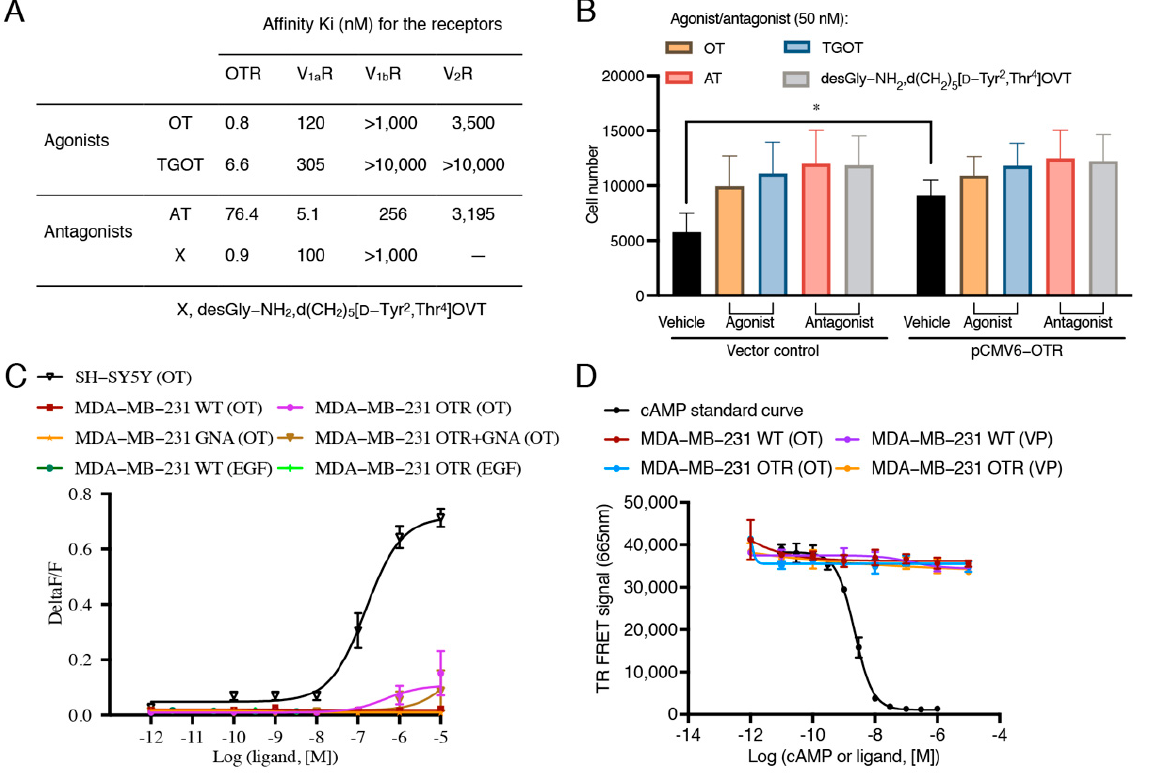
Figure 3. Effects of oxytocin receptor agonists and antagonists on migration ability and effects of oxytocin on intracellular calcium or cAMP accumulation in MDA ‐ MB ‐ 231 cells. ( A ) Affinity infor ‐ ences [28,29]. ( B ) Effects of OTR agonists and antagonists (50 nM) on cell migration of MDA ‐ MB ‐